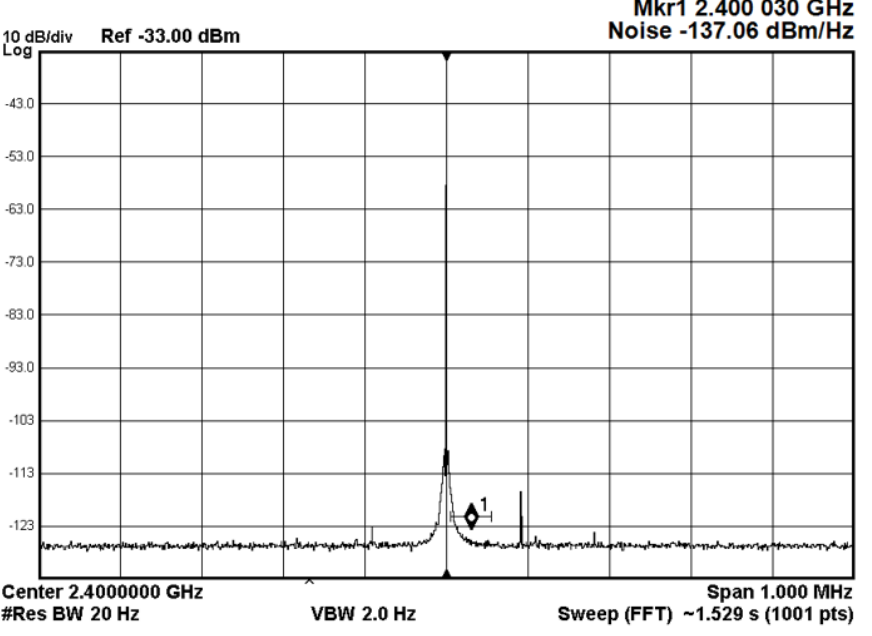
Figure 14. The phase noise of the VSA local oscillator.